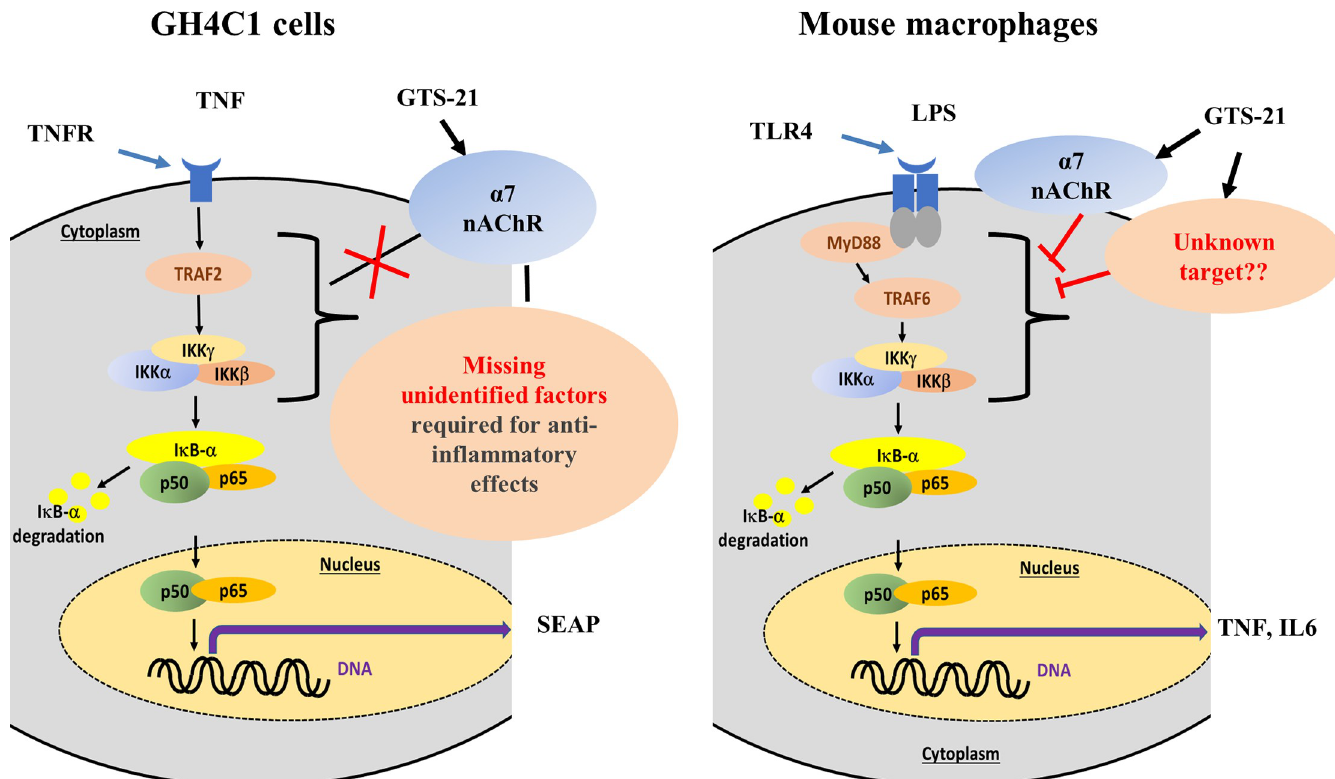
Fig 5. Schematic comparing cell-dependent effects of GTS-21 in GH4C1 cells and primary mouse macrophages. Top panel: GTS-21 was unable to suppress TNF- induced secreted alkaline phosphatase in a α 7 nAChR and NF κ B-SEAP expressing GH4C1 cell system. Bottom panel: GTS-21 reduced LPS-induced TNF and IL6 levels through both an α 7 nAChR-dependent and an α 7 nAChR-independent mechanism in primary mouse macrophages. In both cases, activation of the NFkB pathway leads to phosphorylation of IkB, and dimerization and translocation of two subunits of cytoplasmic NF κ B (usually p50 and p65) to the nucleus to act as a transcription factor (Lawrence et al., 2009). In spite of the common NFkB pathway, the immediate effects of TNF and LPS differ in terms of the receptors and linkage to NFkB signaling, where GTS-21 non-nicotinic receptor actions may be taking place.